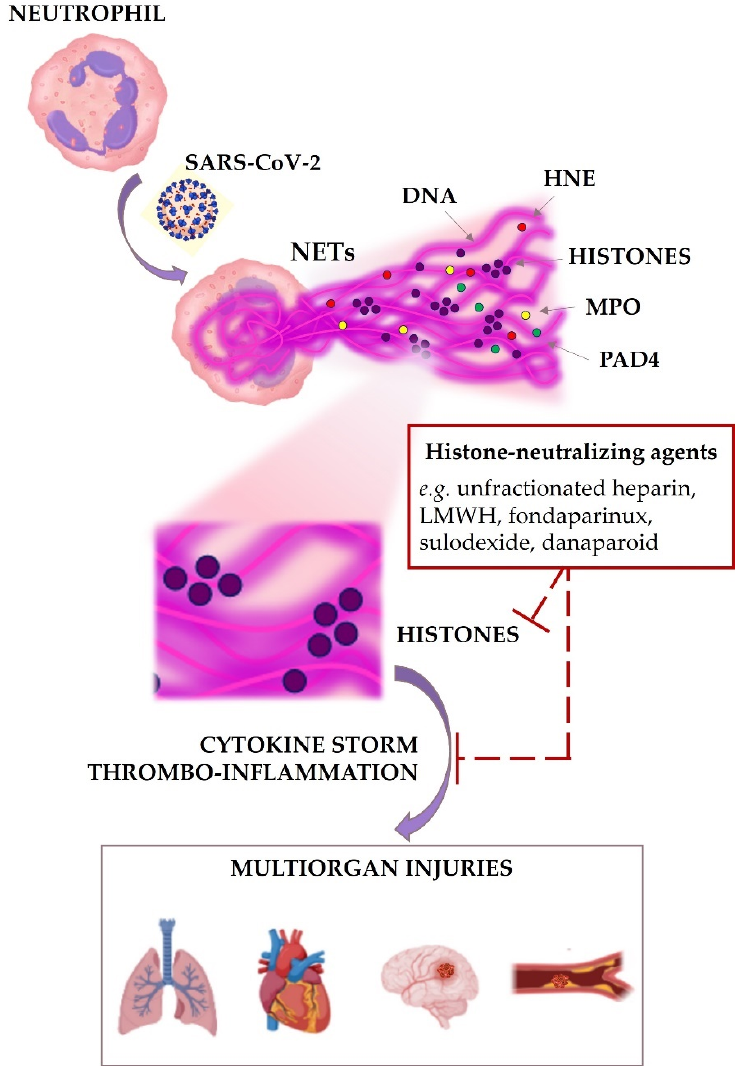
Figure 1. Histones as missing link among COVID-19 infection and multiorgan injuries. Among the main NET biomolecules, we focused attention on pathogenetic mechanisms of excess of histones potentially involved in multiorgan failure, coagulopathy, and systemic hyperinflammation during COVID-19 infection, and their possible therapeutic modulation by clinically used histone-neutralizing drugs (e.g., heparin and heparinoids). (NETs, neutrophil extracellular traps; DNA, deoxyribonucleic acid; HNE, human neutrophil elastase; MPO, myeloperoxidase; PAD-4, peptidylarginine deiminase-4; LMWH, low molecular weight heparins; HISTONES, positively charged multifunctional nuclear proteins).